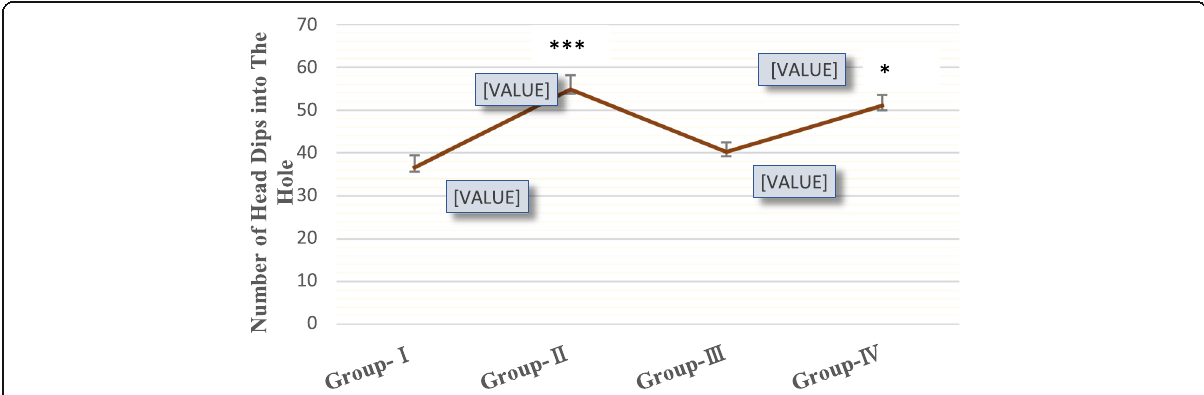
Fig. 3 Effect of Psidium guajava Linn leaves extract on the number of head dips into the holes in hole-board model. Group I = control group, group II = positive control group, group III = Psidium guajava Linn low strength group, group IV = Psidium guajava Linn high strength group. * p < 0.05, *** p < 0.001 vs group